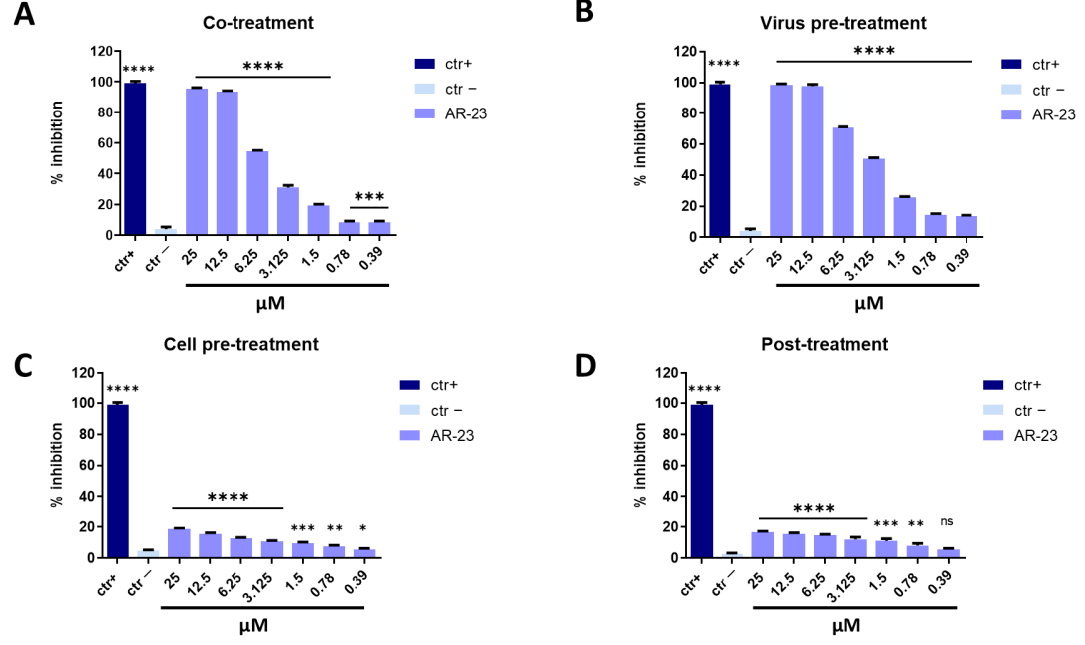
Figure 5. Antiviral activity against HPIV-2. Different assays were performed in order to evaluate anti-HPIV-2 activity. ( A ) Co-treatment: simultaneous addition of AR-23 and virus to the cells; ( B ) Virus pre-treatment: virus incubated with the peptide, and then used to infect cells; ( C ) Cell pre-treatment: AR-23 incubated with the cells before the viral infection; ( D ) Post-treatment: AR-23 added to the infected cells. Peptide AR-23 inhibited the early stages of infection, acting in co-treatment ( A ) and virus pre-treatment ( B ) assays, while it was not able to interact with the cellular surface ( C ) or block the viral replication ( D ). Different compounds were used as positive control (ctr+) for each treatment: mucroporin M1 ( A , B , 10 µ M for both the assays) [40], FIP peptide (C, 20 µ M) [41], and 5 (cid:48) -nor carbocyclic adenosine analogue (D, 5 µ M) [42], while infected cells were used as negative control (ctr-). **** p < 0.0001; *** p < 0.0002; ** p < 0.0021; * p < 0.021; ns: